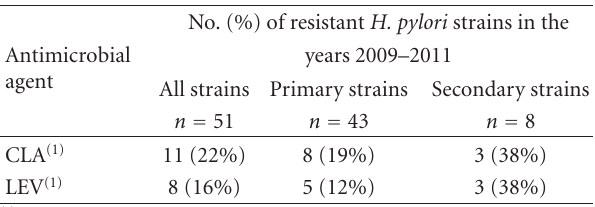
Table 1: Comparison of resistance of H. pylori primary and sec- ondary strains to clarithromycin and levofloxacin in 2009–2011.